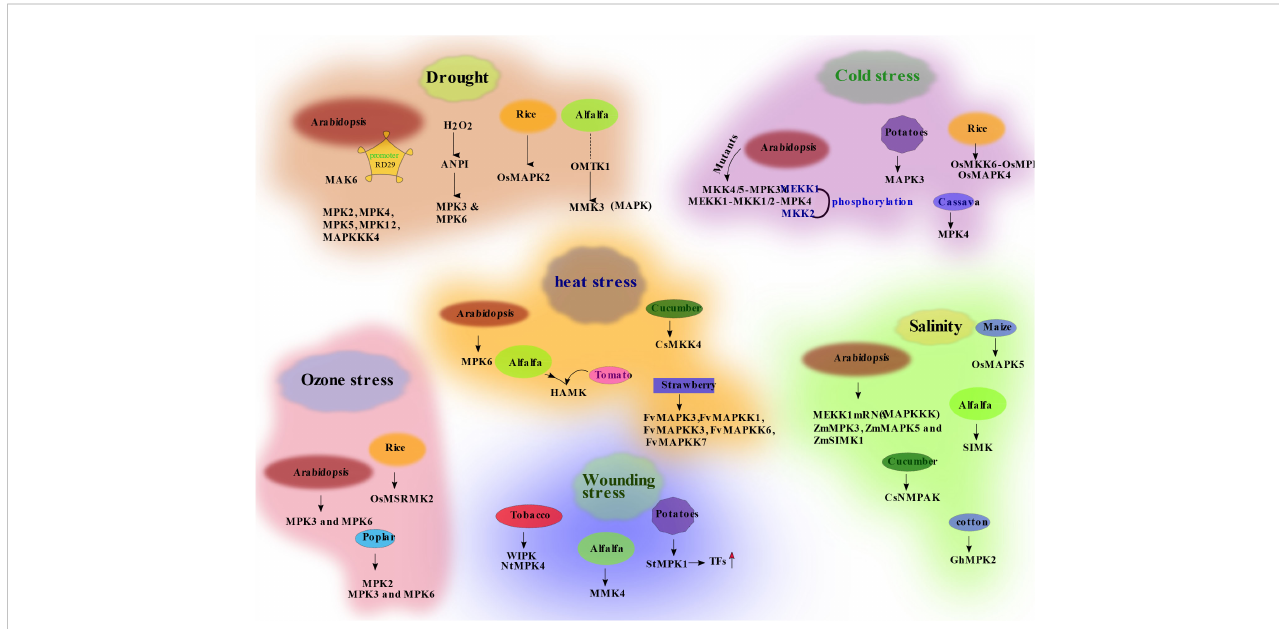
FIGURE 3 The schematic diagram of different mitogen-activated protein kinase (MAPK) signaling molecules under different stress conditions in different crops. Solid arrows show veri fi ed pathways; dashed arrows indicate assumed pathways; question marks indicate unknown cascade